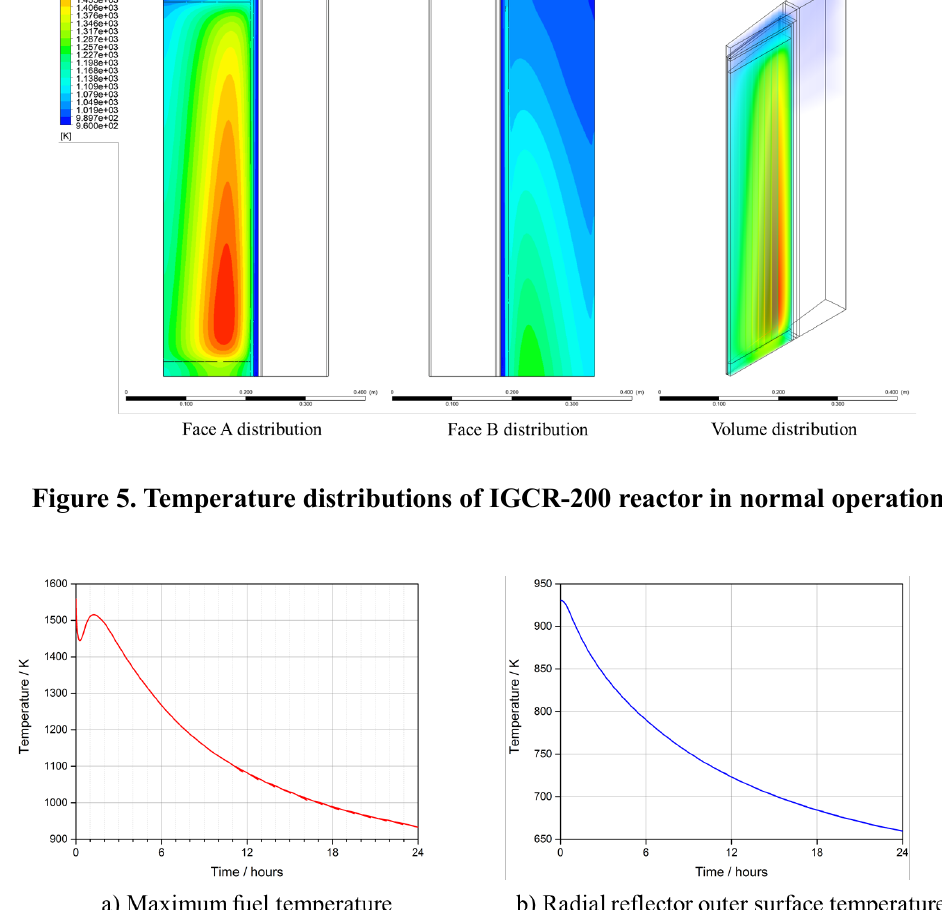
Figure 6. Temperate changes with time in LOCA